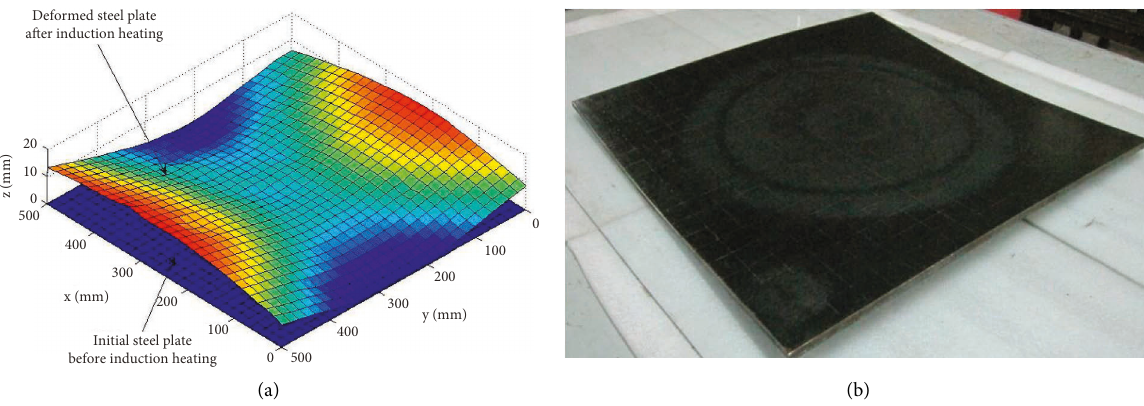
Figure 14: Measurement results: (a) saddle transformation with the symmetric steel plate and (b) experiment on the specimen with its relative